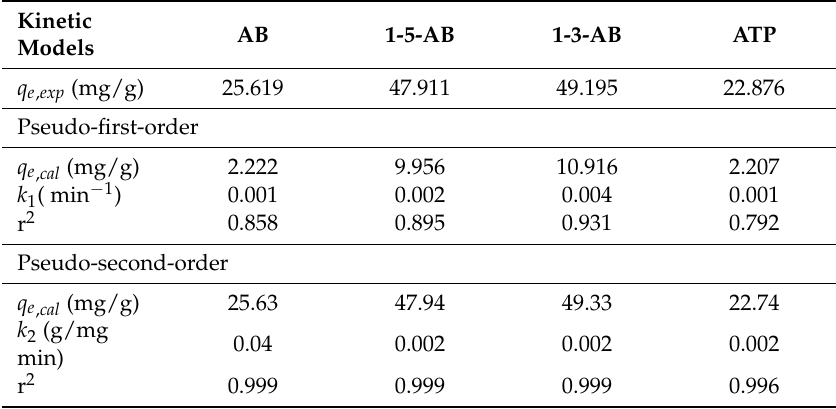
Table 5. Pseudo-first-order and pseudo-second-order constants and correlation coefficients for the adsorption of RBR on the biochar